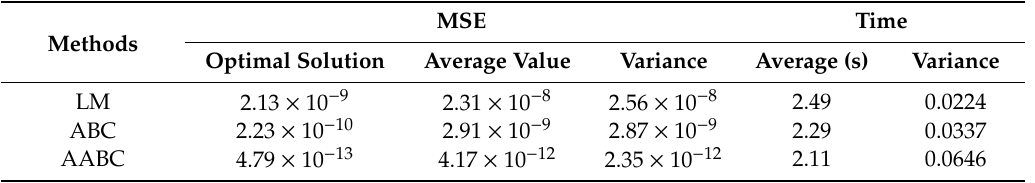
Table 3. Comparison results of AABC, ABC and LM.